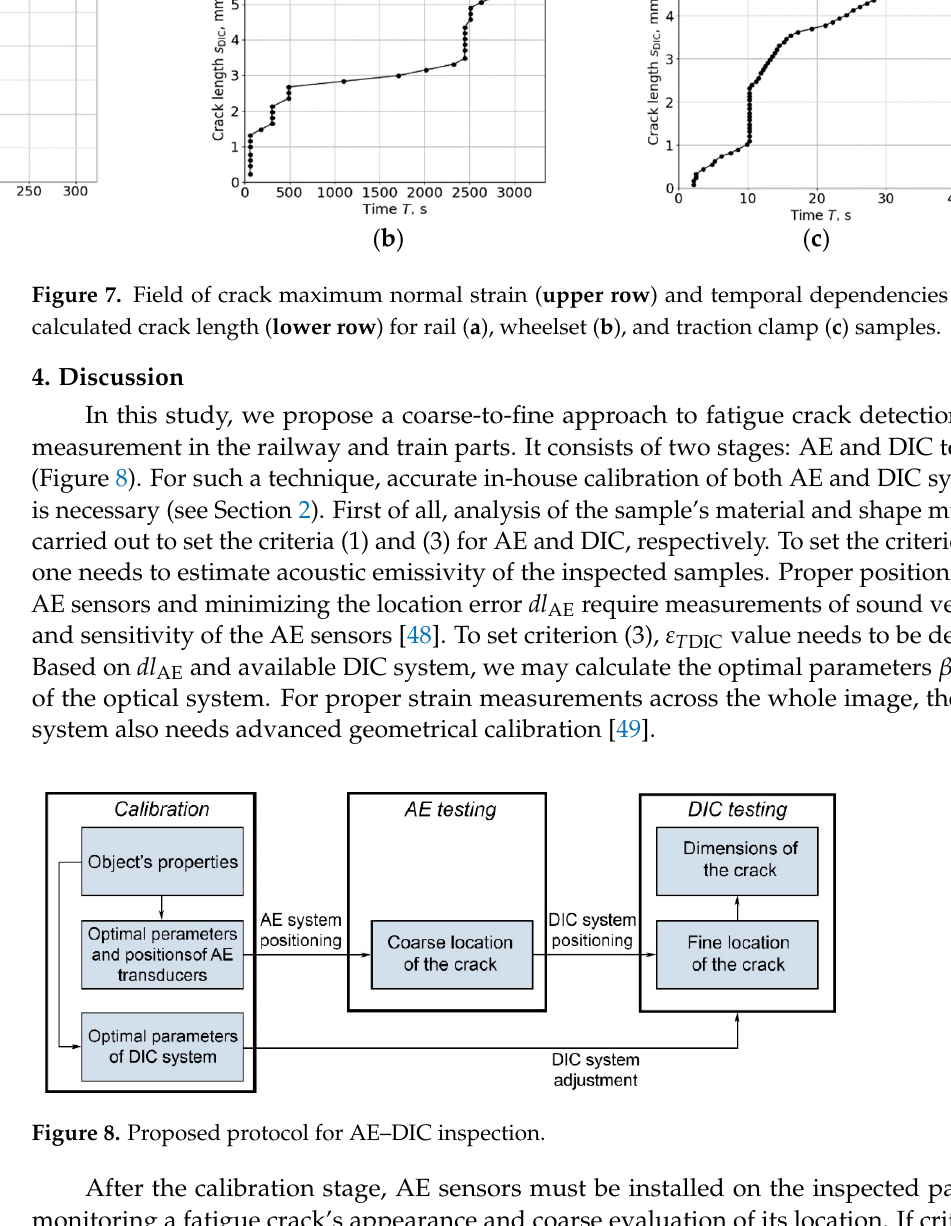
Figure 8. Proposed protocol for AE–DIC inspection.